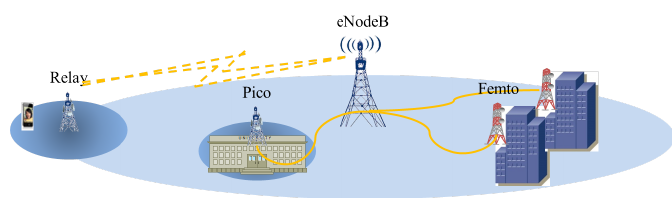
Figure 1. Illustration of a